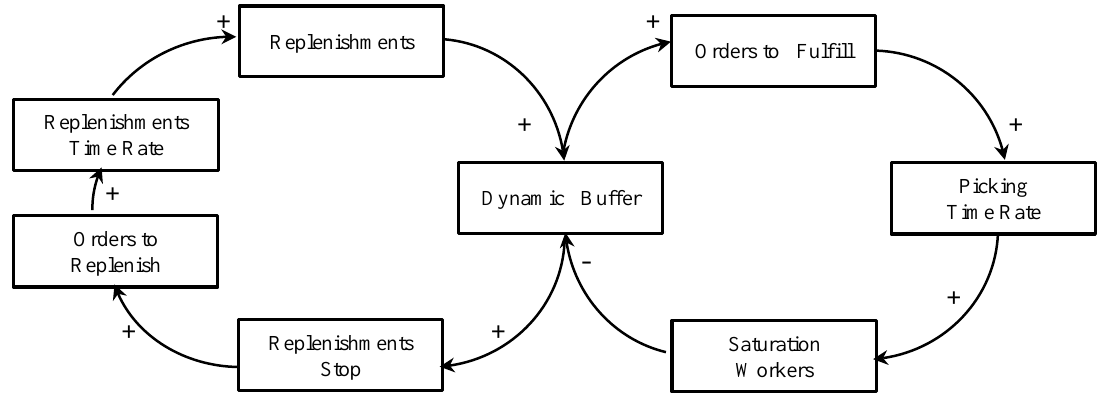
Fig. 1. Dynamic buffer: Causal Loop Diagram